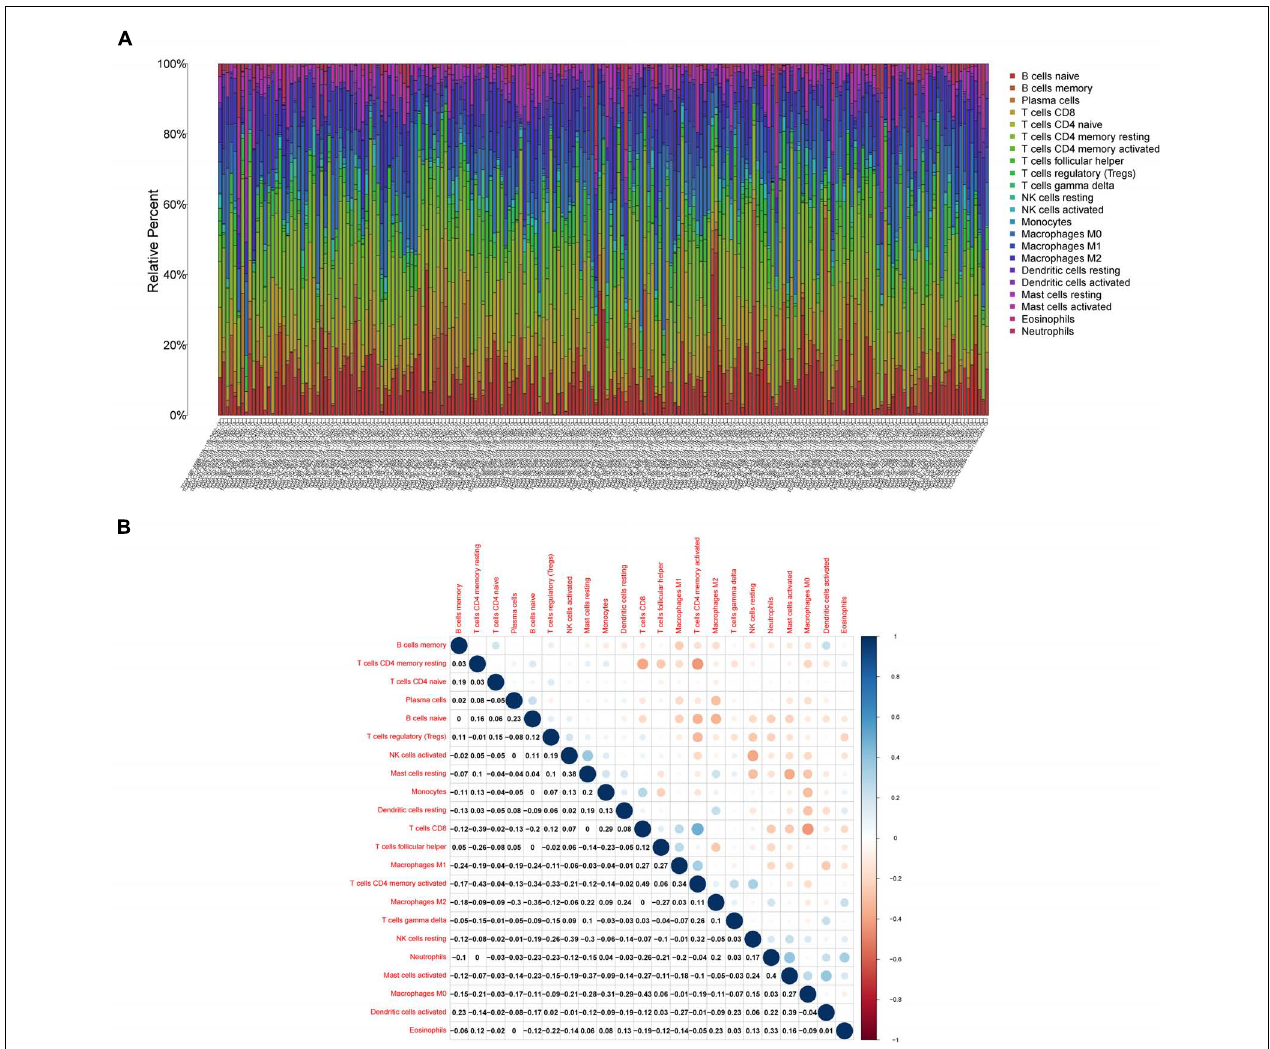
FIGURE 8 | Profiles of tumor-infiltrating immune cells (TIICs) in gastric cancer (GC) samples and their correlation analysis. (A) Barplot showing the proportion of 21 different types of TIICs in GC tumor samples. (B) A heatmap showing the correlation between 21 different types of